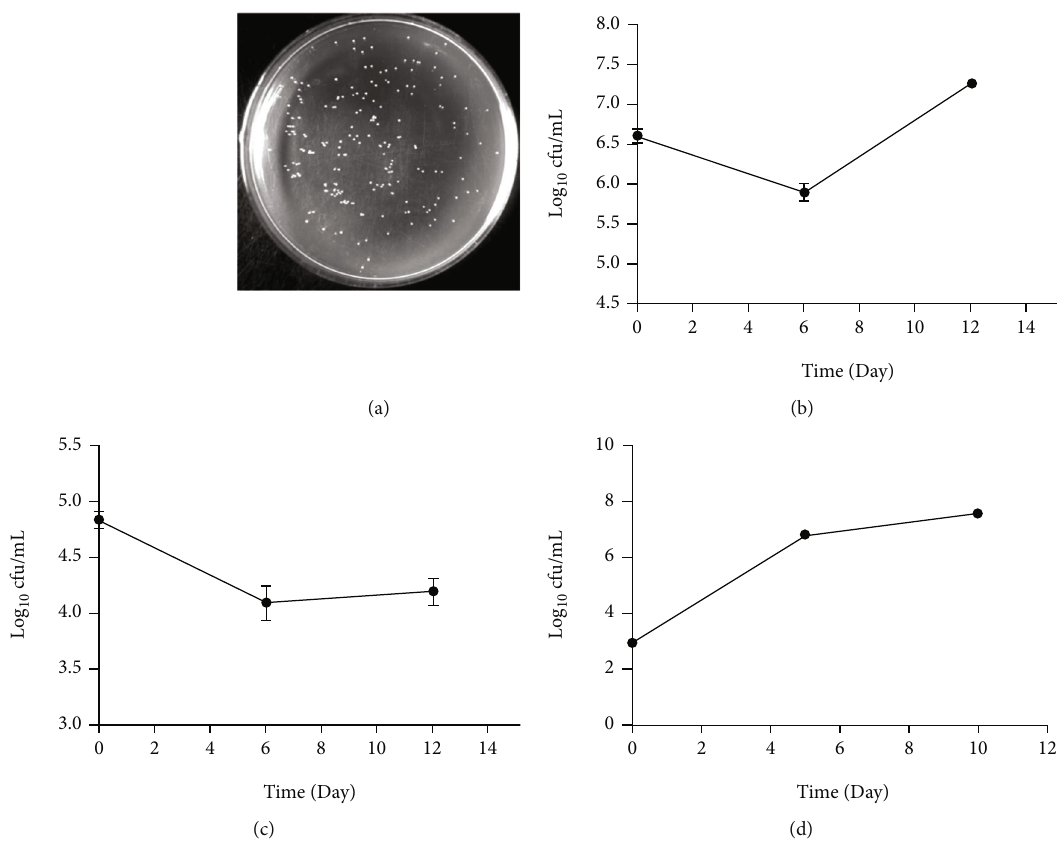
Figure 2: Bacteriological analysis of ulcer wound exudate in diabetic foot patients. (a) The growth morphology of colonies in exudate samples on LB plates, with smooth edges and milky color colonies (about 0.5mm in diameter). (b) The number of colony-forming units in the exudate of patient No. 1 ranged from 10 4-7 CFU/mL, and the changes in the early, middle, and late stages were fi rst decreased and then increased. (c) The number of colony-forming units in the exudate of patient No. 2 ranged from 10 4-5 CFU/mL, and the change trend also decreased fi rst and then increased slightly. (d) The number of colony-forming units in the exudate of patient No. 3 was between 10 3-8 CFU/mL, with a large range of change and a gradual increase, with a large range in the early and middle stages and a small range in the middle and late stages.